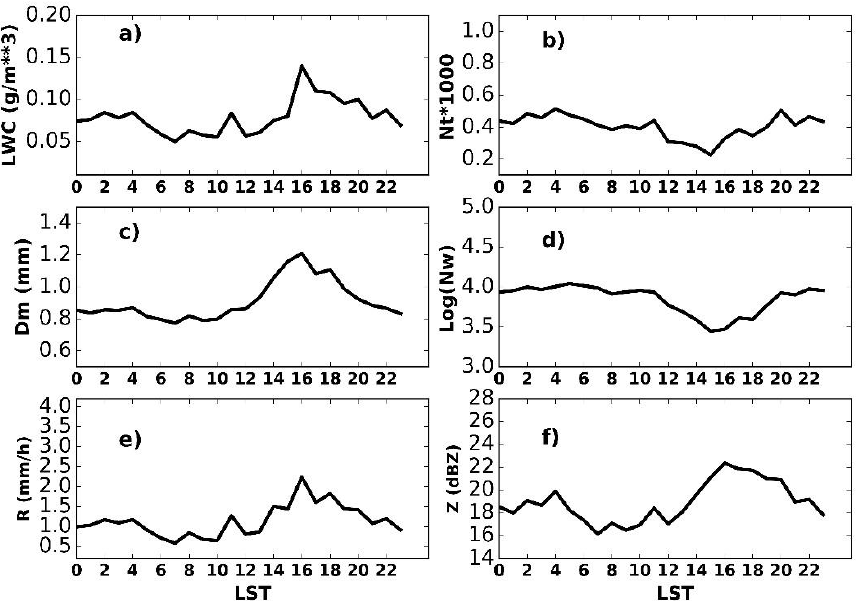
Figure 11. Diurnal cycle of ( a ) Liquid water content (LWC), ( b ) Total concentration number (Nt), ( c ) Mass-weighted drop diameter (Dm), ( d ) normalized intercept parameter (Nw), ( e ) rain rate (R), ( f ) reflectivity (Z).